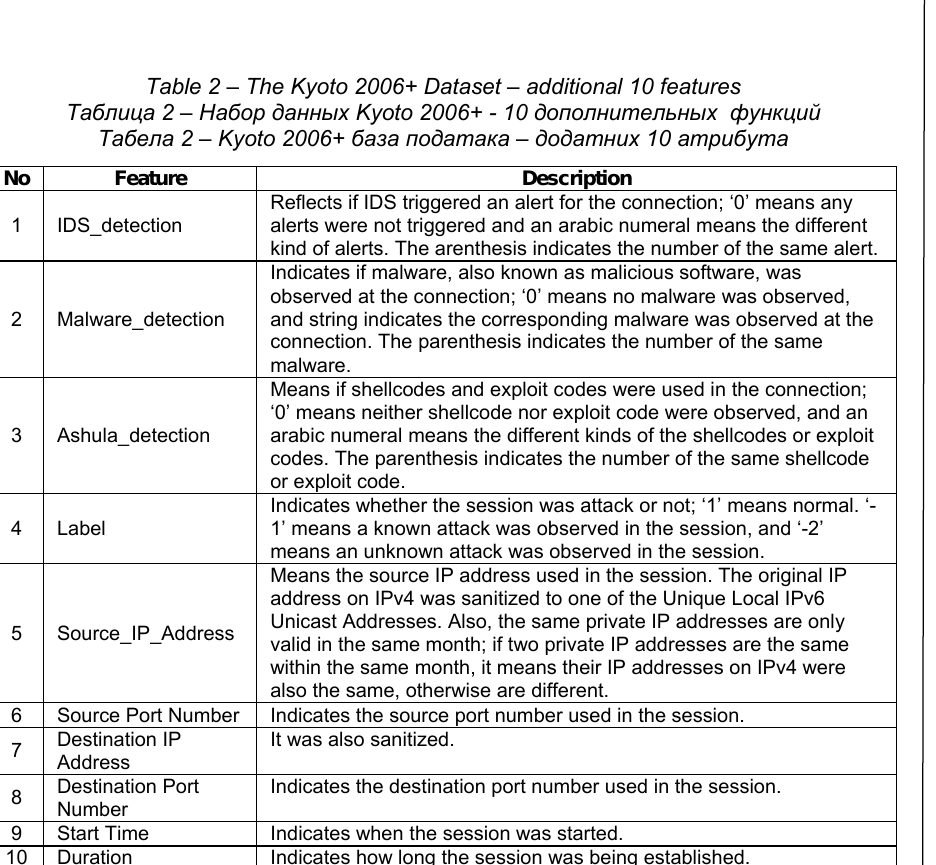
611 Table 2 – The Kyoto 2006+ Dataset – additional 10 features -